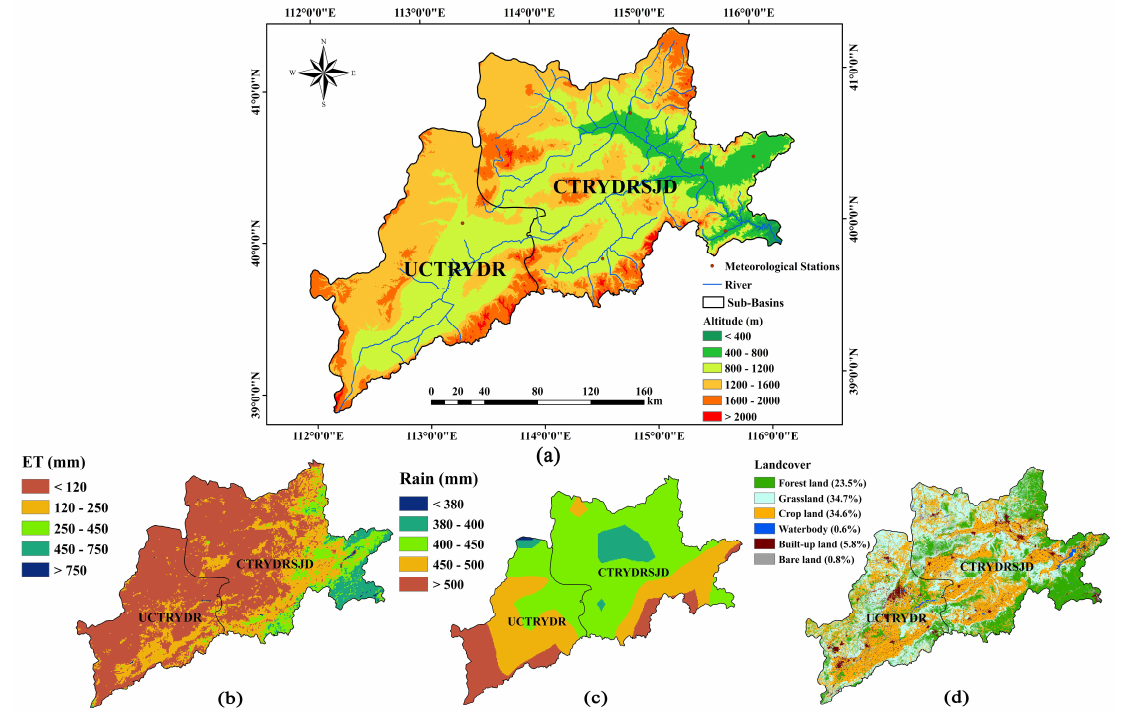
Figure 1. ( a ) Locations and altitudes of the YD River Basin, meteorological stations and rivers; ( b ) ET distribution map; ( c ) rainfall distribution map; ( d ) land cover map of the YD River